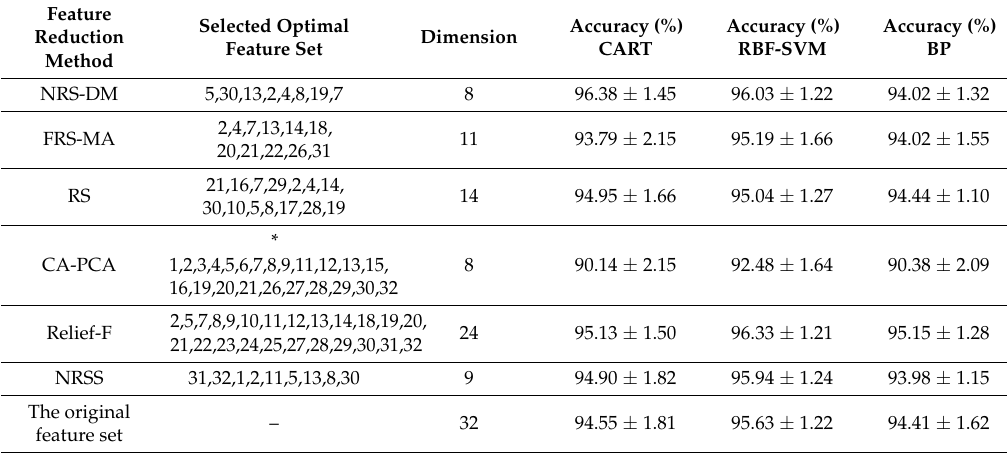
Figure 8. Performance comparison of different feature reduction methods (ASS14). Table 6. Comparison of different feature reduction methods